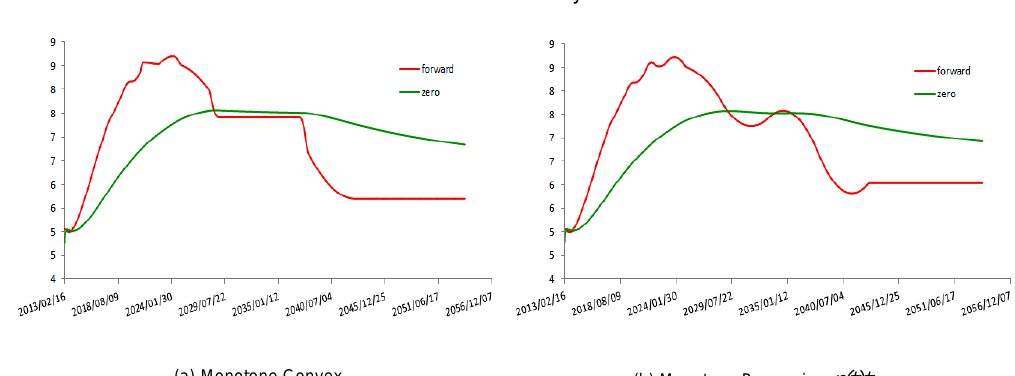
Spot and 90-day forward curves obtained by bootstrapping the South African swap curve on 15 February 2013